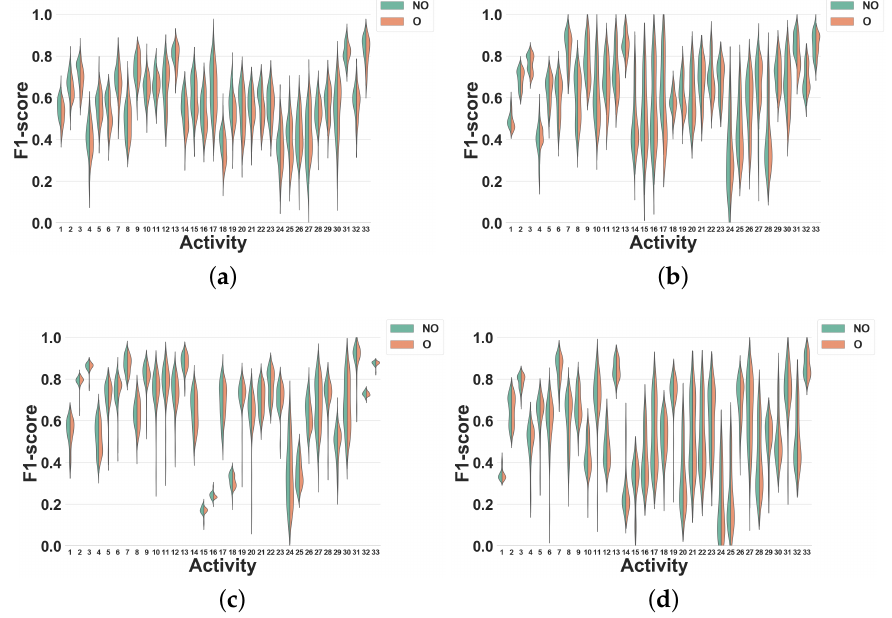
Figure 11. Experiment 4–Subject-independent CV–Dataset 1. ( a ) DT; ( b ) KNN; ( c ) NB; ( d ) NCC. Dataset 2. Our results for this experiment are shown in Figure 12.